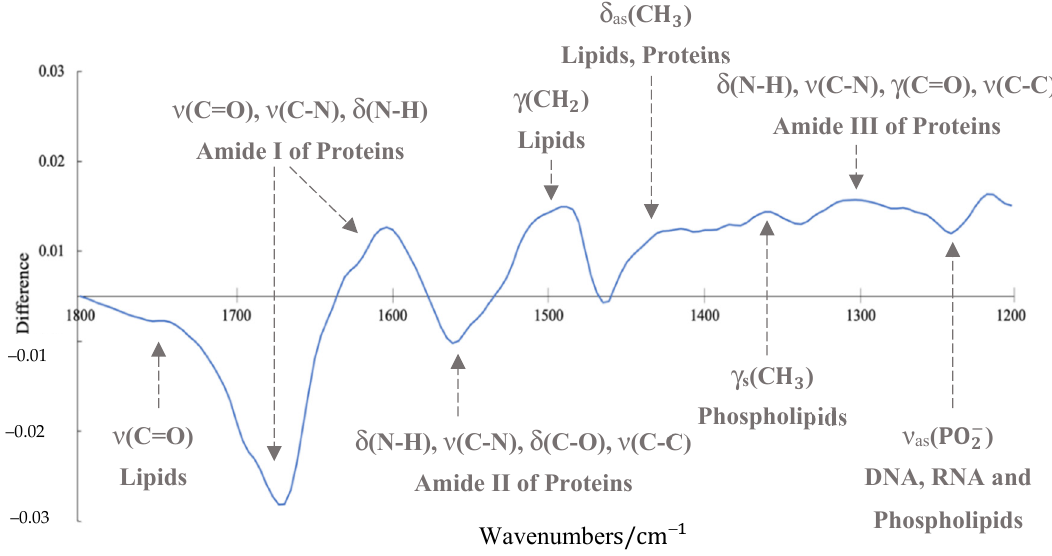
Figure 7. Di ff erence spectrum of mean IDH1 -mutated and IDH1 -wildtype absorbance spectra for the synchrotron-based IDH1 dataset, with tentative biological assignments and associated vibrational modes: ν = stretching; δ = bending; γ = wagging, twisting and rocking; as = asymmetric; s = symmetric.